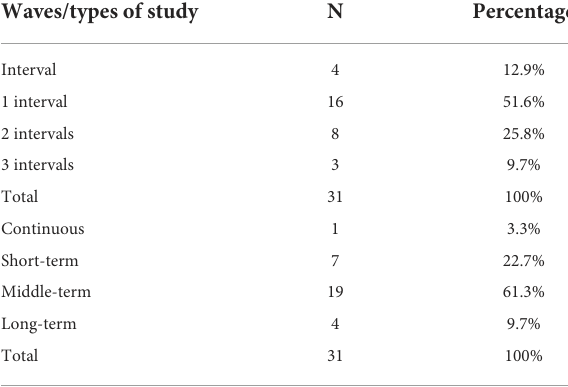
TABLE 6 Characteristics of study design (waves of data and